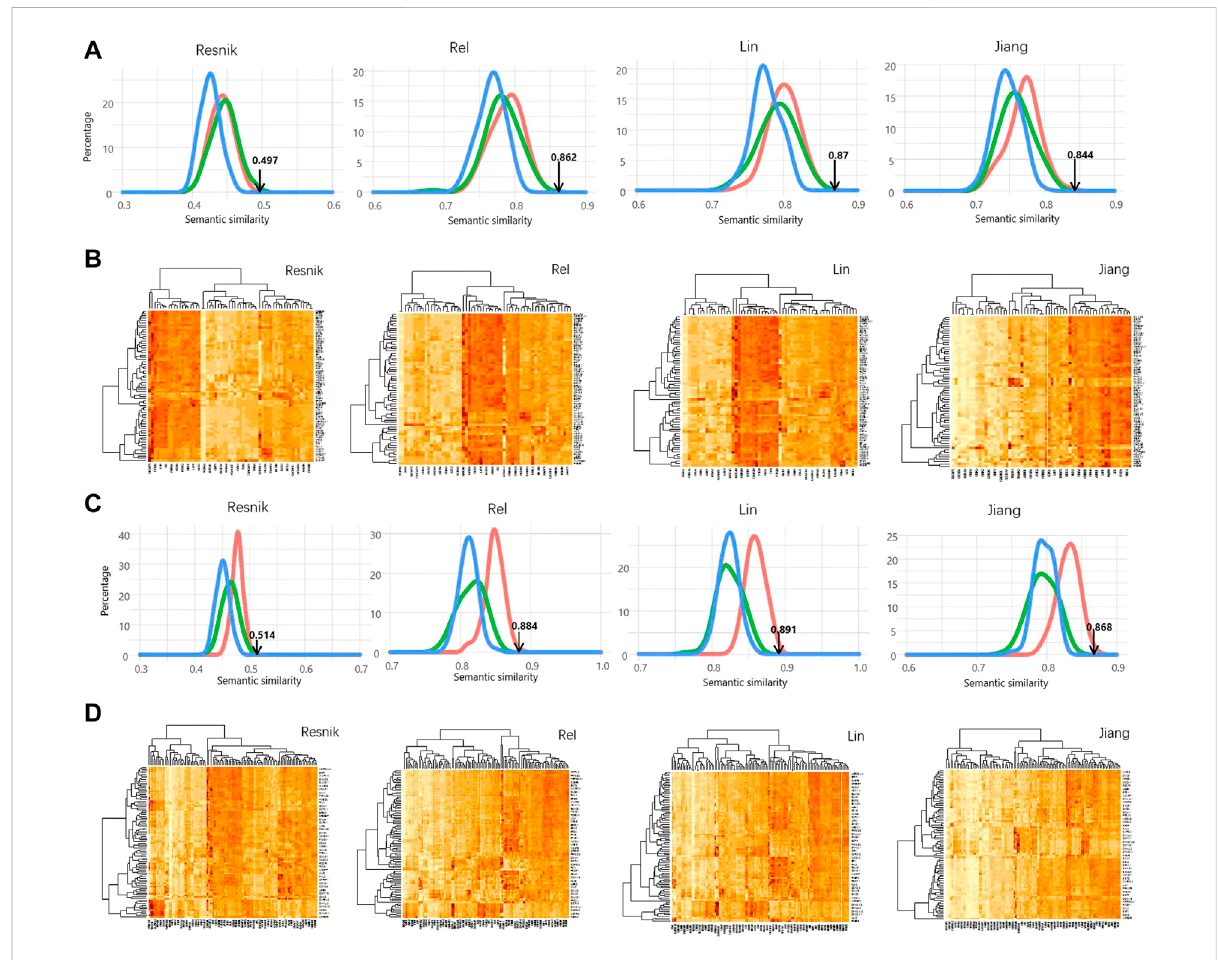
FIGURE 2 Signi fi cant high semantic similarity between AR interactors and PSD95 interactors. (A) Distribution of the simulated SS scores calculated using four different methods. The simulation methods were colored the same as Figure 1. (B) Heatmap showing the semantic similarity between AR interactors and PSD95 interactors using the four methods. Interaction con fi dence score of 0.9 was used in (A,B) . (C) Distribution of the simulated SS scores calculated using four different methods. (D) Heatmap showing the semantic similarity between AR interactors and PSD95 interactors using the four methods. Interaction con fi dence score of 0.95 was used in (C,D)